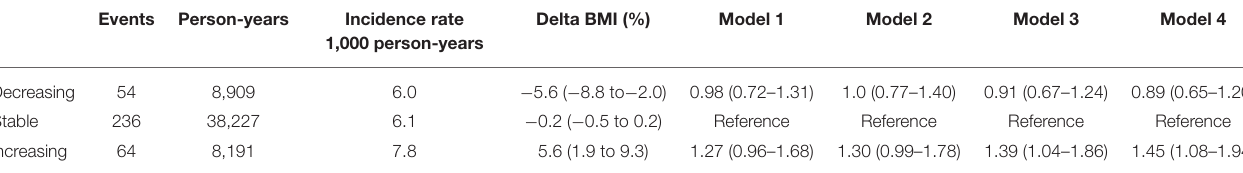
TABLE 2 | Hazard ratios for the incident chronic kidney disease according to the body mass index trajectory